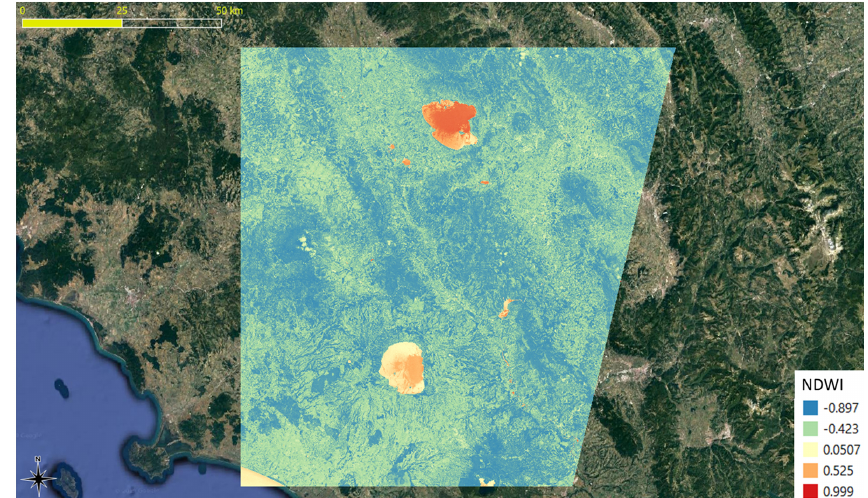
Figure 6. Example of the NDWI (computed using the imagery acquired on 13 July 2018) in QGIS software. ©Google Map source: Immag- ini©2018 TerraMetrics, Dati Cartografici©2018.